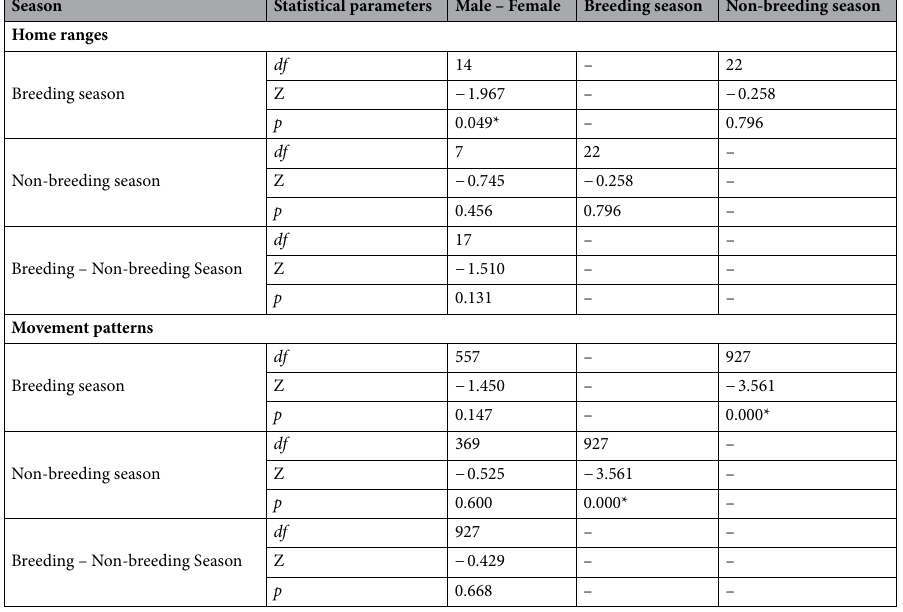
Table 3. Comparison of home ranges and movement patterns of L. catesbeianus between sexes and periods. ‘*’ = The difference is significant at the 0.05 level